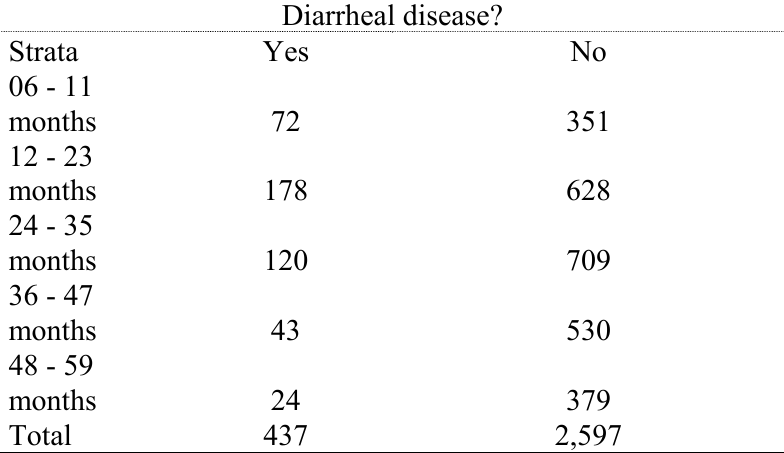
Table 2. Age strata of 437 children with diarrhea in